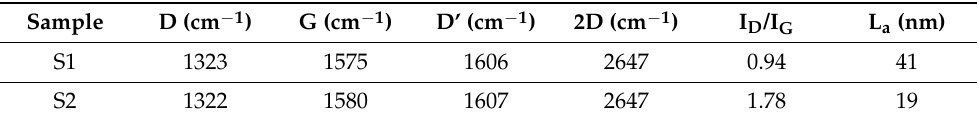
Figure 3. Raman spectra of samples S1 (black curve) and S2 (blue curve). Decomposition of the G peak into Lorentzian spectra (green and red curves). Table 2. Characteristics of Raman spectra of MWCNTs.